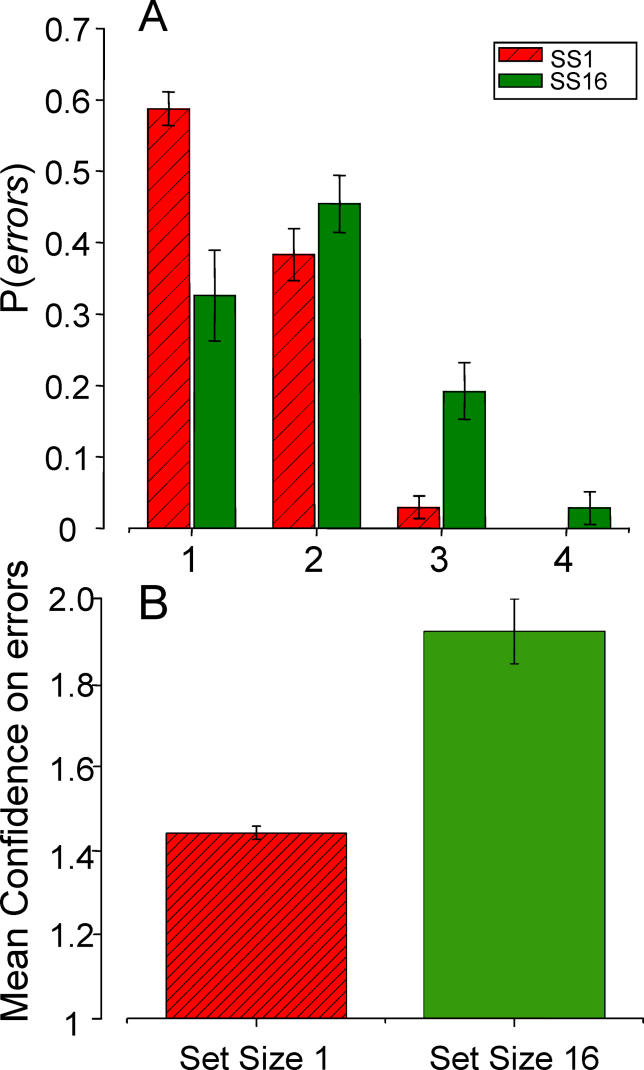
Confidence Ratings for Error Trials at Near-Threshold TiltsThe top histogram plots the proportion of responses of error trials at each confidence level, averaged across four observers (all naive of the goals of the experiment). The green bars show responses for set size 16, and the red patterned bars show responses for set size 1, with bars showing ± 1 SEM. In the lowest confidence level, the proportion of errors is higher at set size 1 than at set size 16, while at the three higher confidence levels, the reverse holds. The differences at confidence levels 1 and 3 were statistically significant (Studentt test,p < 0.01). The difference was insignificant at confidence level 2 (where the proportions were similar), and also at level 4 (by binomial test), as there were only five responses in this bin (observers tended to shy away from the response extremes). The bottom bar graphs plot the mean confidence averaged across the same four observers in the set size 1 (patterned red bar) and set size 16 (green bar) condition. The error bars show ± 1 SEM, revealing that our subjects were more confident about their erroneous responses in with a cluttered display than in a single stimulus (Studentt test,p < 0.001).